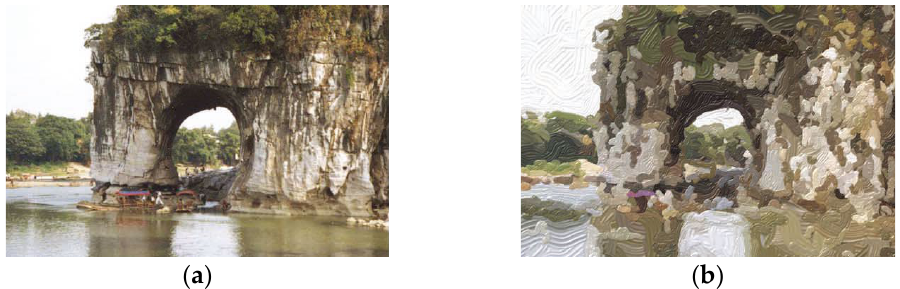
Figure 1. A computer-generated oil-painting art image created by Hertzmann [2]. ( a ) The original input image. ( b ) The created art image has an effect of oil painting with brush strokes.